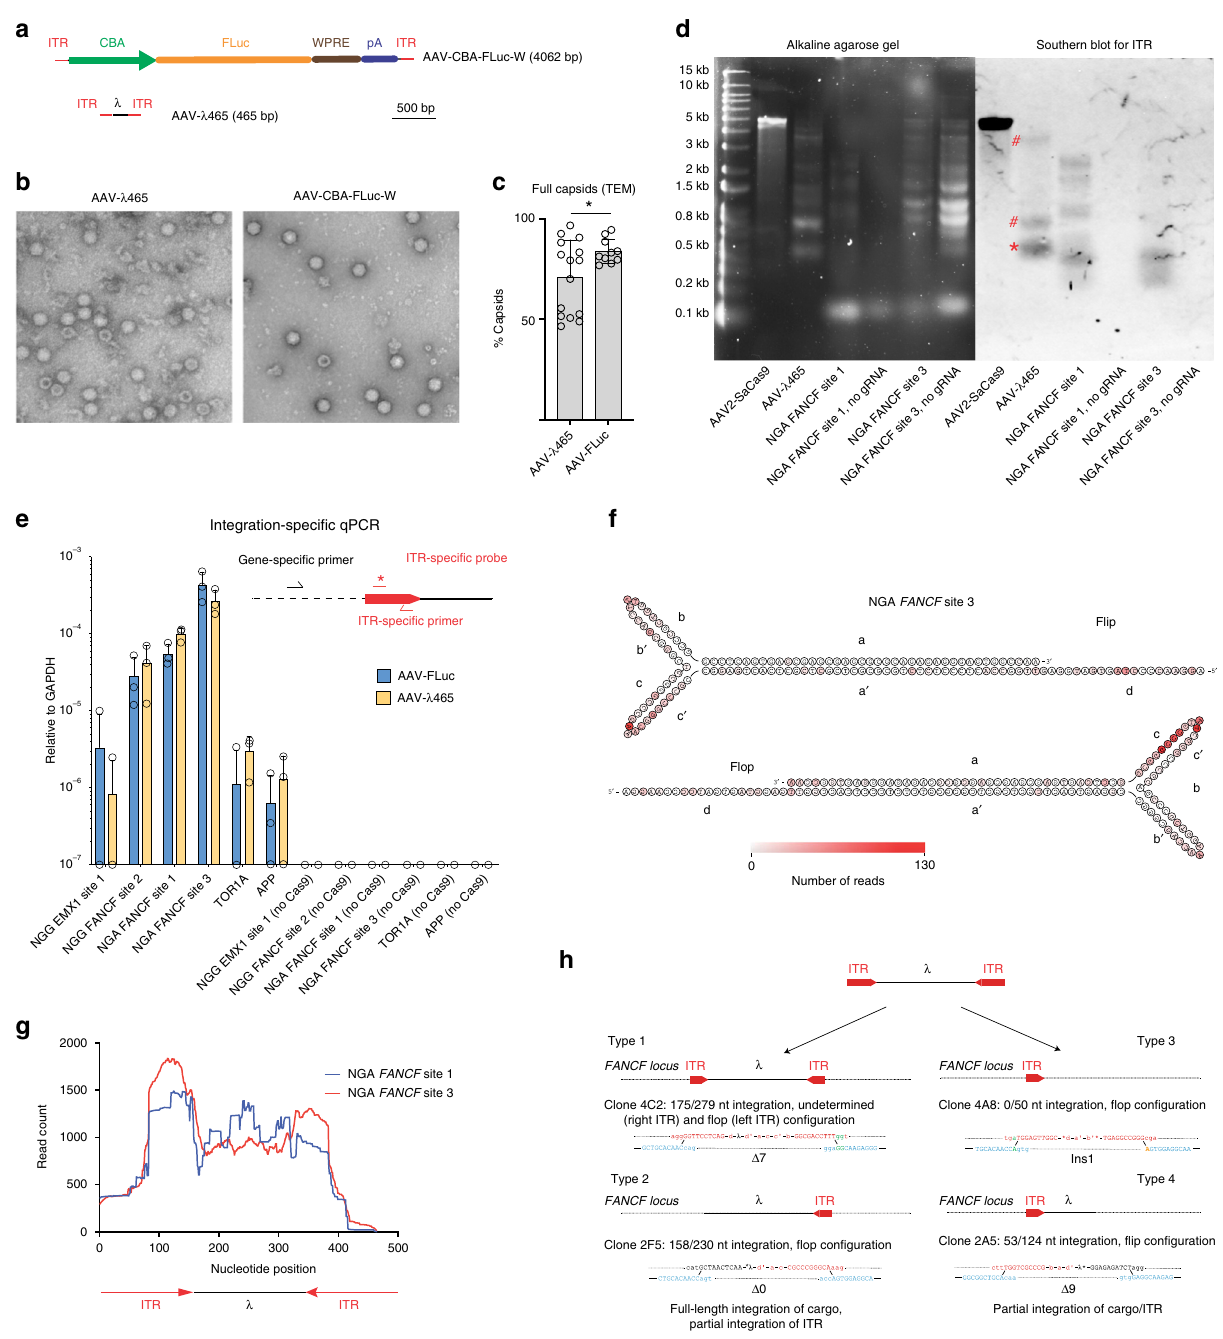
Fig. 3 Characterization of AAV vector integration into CRISPR cut sites using a miniaturized AAV genome. a Schematic of standard-sized AAV-CBA-FLuc vector (top, 4062 bases) vs miniaturized AAV- λ 465 (bottom, 465 bases). Chart is to scale. b Transmission electron microscopic examination of iodixanol gradient-puri fi ed capsids of AAV2- λ or AAV2-CBA-FLuc. c quantitation of full vs empty capsids (bars represent mean ± SEM, data from two independent experiments, 15 and 10 images were taken and 954 and 1231 capsids were counted for AAV- λ 465 and AAV-CBA-FLuc, respectively, and p = 0.0254, unpaired t -test). d Alkaline gel electrophoreses and Southern blot for AAV genomes from iodixanol puri fi ed vectors (AAV2-CMV::NLS-SaCas9-NLS-3xHA- bGHpA;U6::BsaI-sgRNA (pX601, 4.8 kb size) and AAV- λ 465 (465 bp size) and cellular genomic DNA containing integrated AAV- λ 465. For Southern blot, we used a probe speci fi c for the ITR region. Star (*) highlights the 465 bp expected band and pound (#) sign highlights concatemers in the AAV- λ 465 genome. e ITR-genomic fusion events quanti fi ed by integration-speci fi c qPCR assay, using AAV- λ 465 or AAV2-CBA-FLuc vectors determined (bars represent mean ± SD). Three independent experiments were performed using two technical replicates each. f Heatmap of AAV speci fi c ITR nucleotide integration at CRISPR cut site. More saturated red indicates higher frequency of breaks at the given position. g Integration pro fi le of the entire miniaturized AAV genome from U2-OS cells. h Representative individual AAV integration clones showing different forms of integration detected (for all the clones, see Supplementary Fig. 4). Source data are provided as a Source Data fi